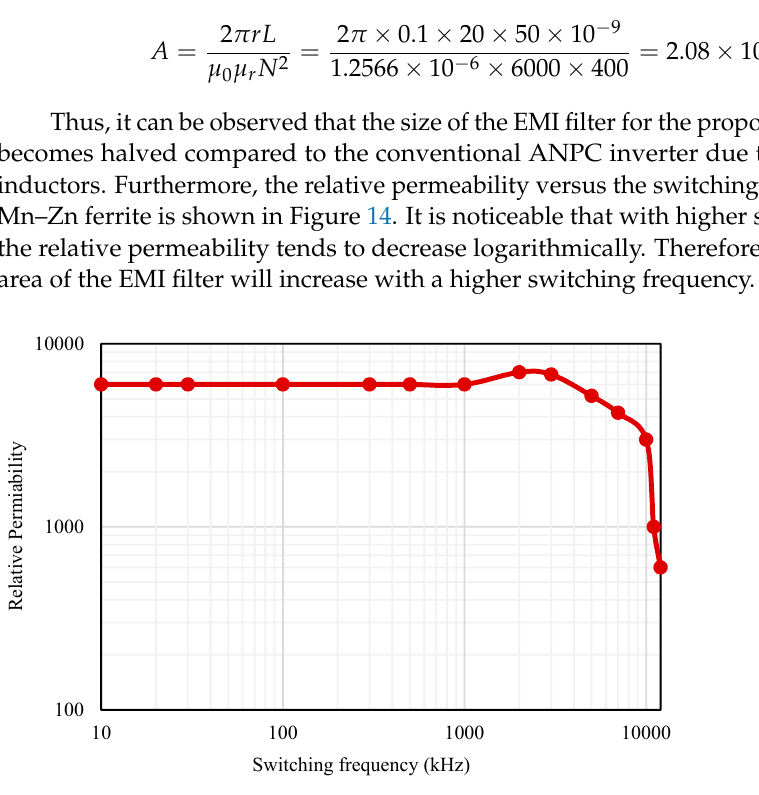
Figure 14. Relative permeability of Mn Zn ferrite under different switching frequencies.